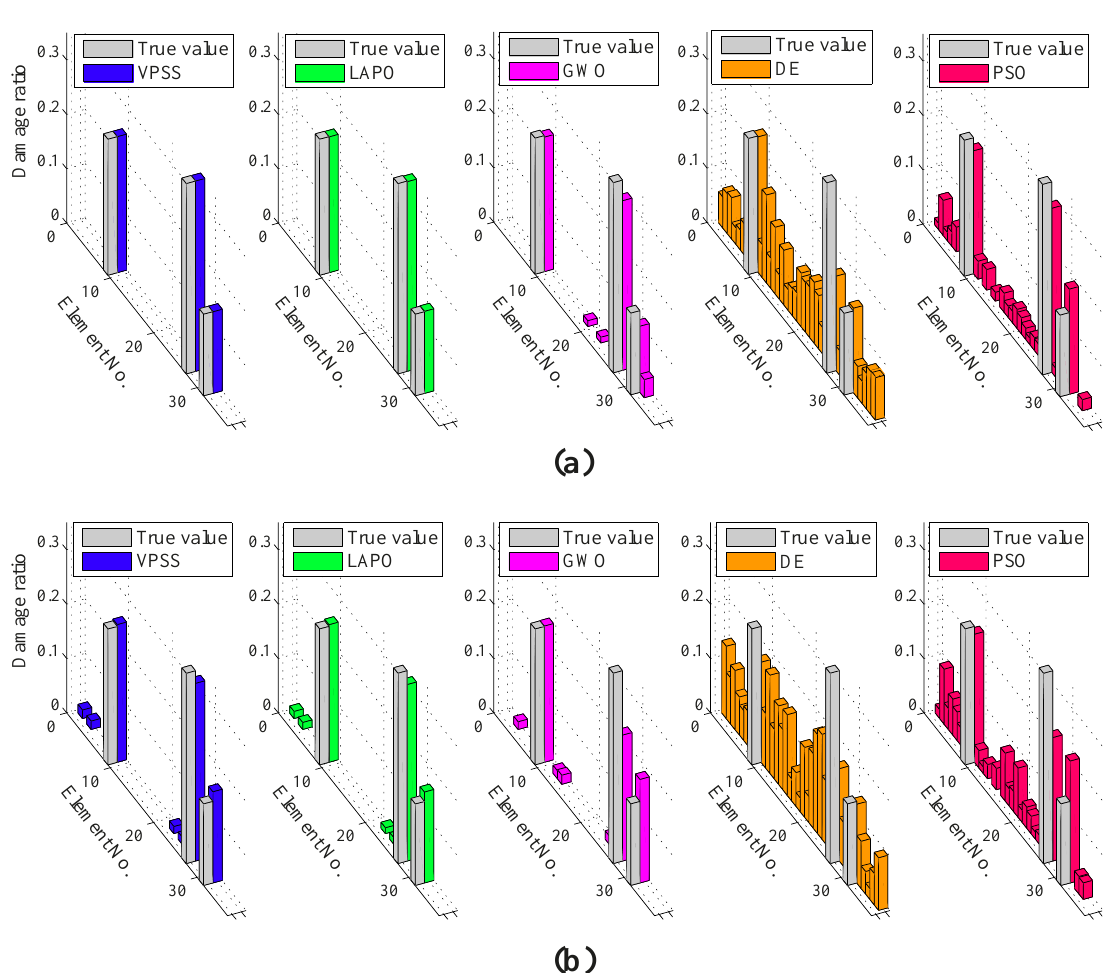
Figure 12. Damage identification results for the two-bay three-story frame under the ( a ) noise-free condition and ( b ) noisy condition. Table 5. Statistical results of the damage identification for the two-bay three-story frame.